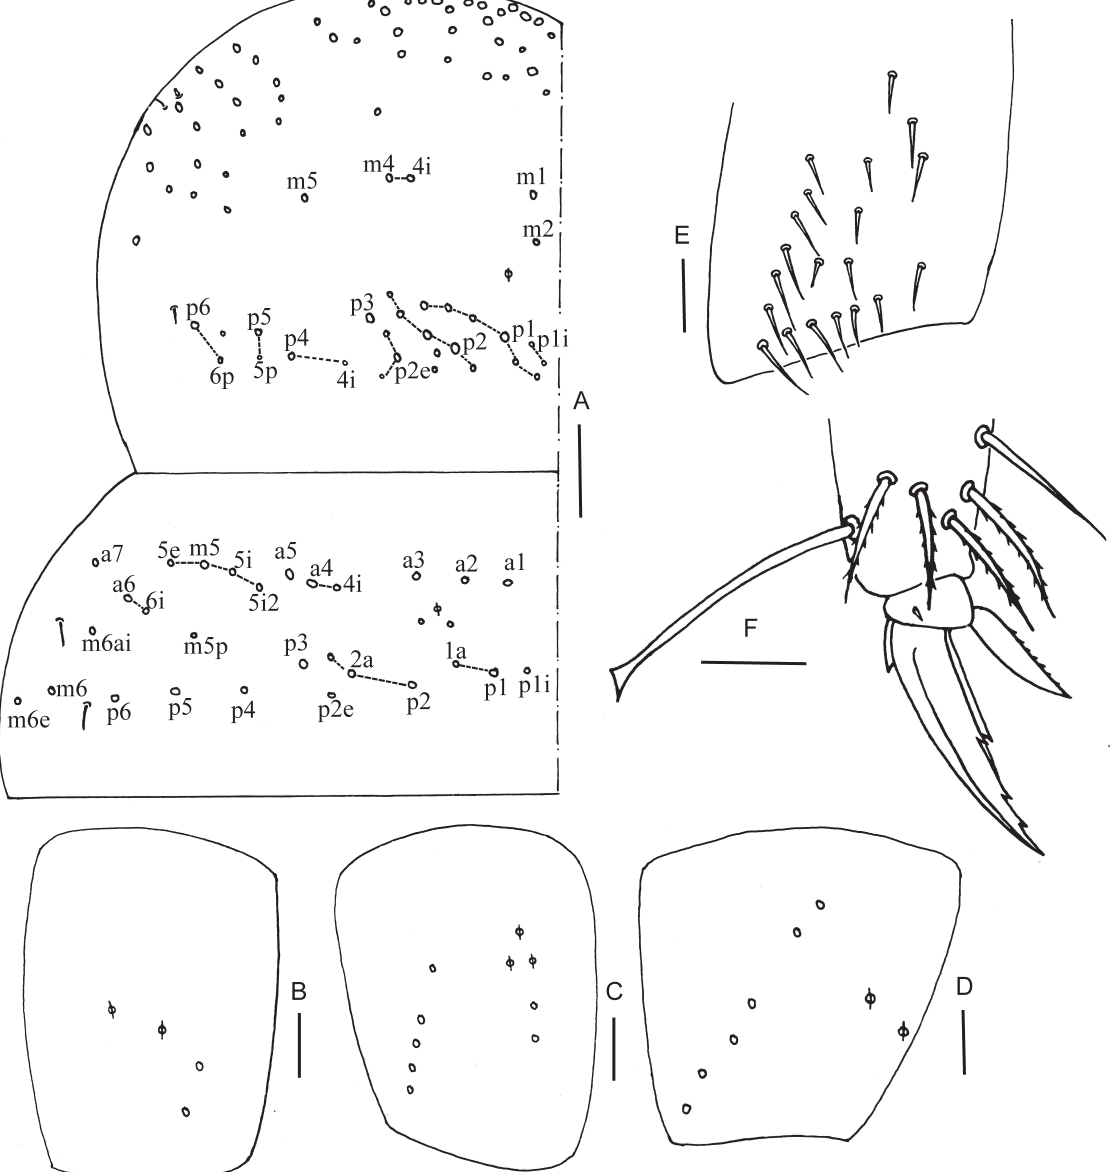
Fig. 13. Entomobrya dingi sp. nov. A . Chaetotaxy of Th. II−III. B . Coxal macrochaetal formula of fore leg. C . Coxal macrochaetal formula of middle leg. D . Coxal macrochaetal formula of hind leg. E . Trochanteral organ. F . Hind foot complex. Scale bars: A = 50 μm; B–F = 20